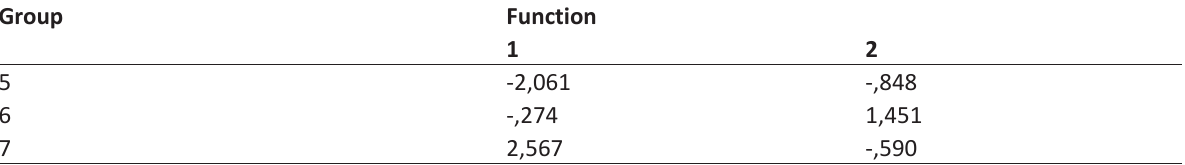
Table 7. Functions at Group Centroids. Boys aged 11-13 years old